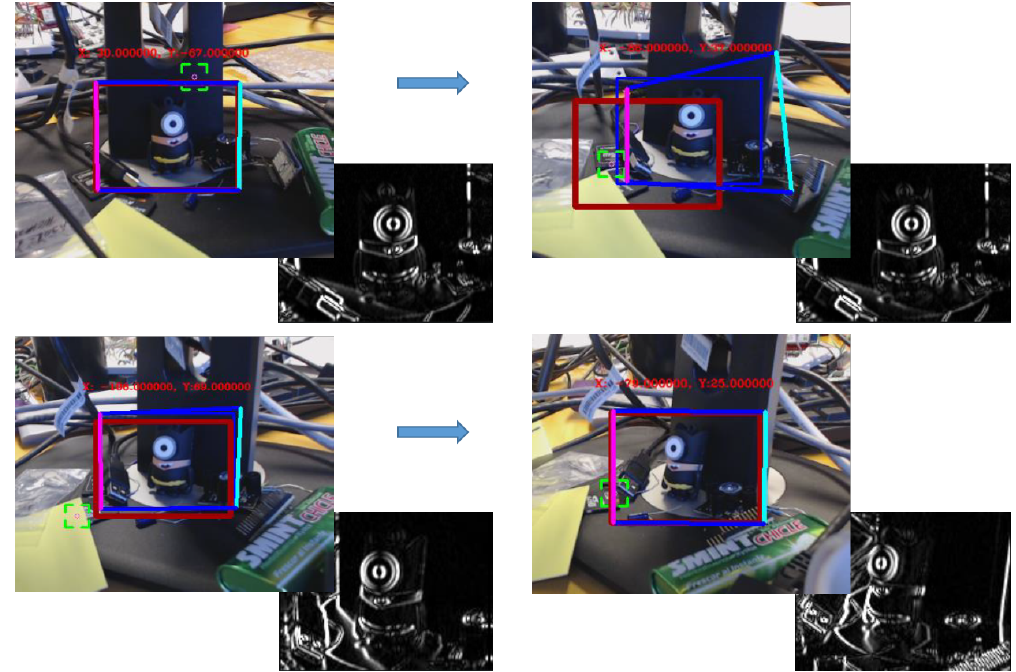
Figure 4. SURF+KCF system sequence working with different patterns in the same execution. The red square shows the position where the pattern was taken. The colourful square depicts the SURF-based homography estimation, and the blue square represents the tracked